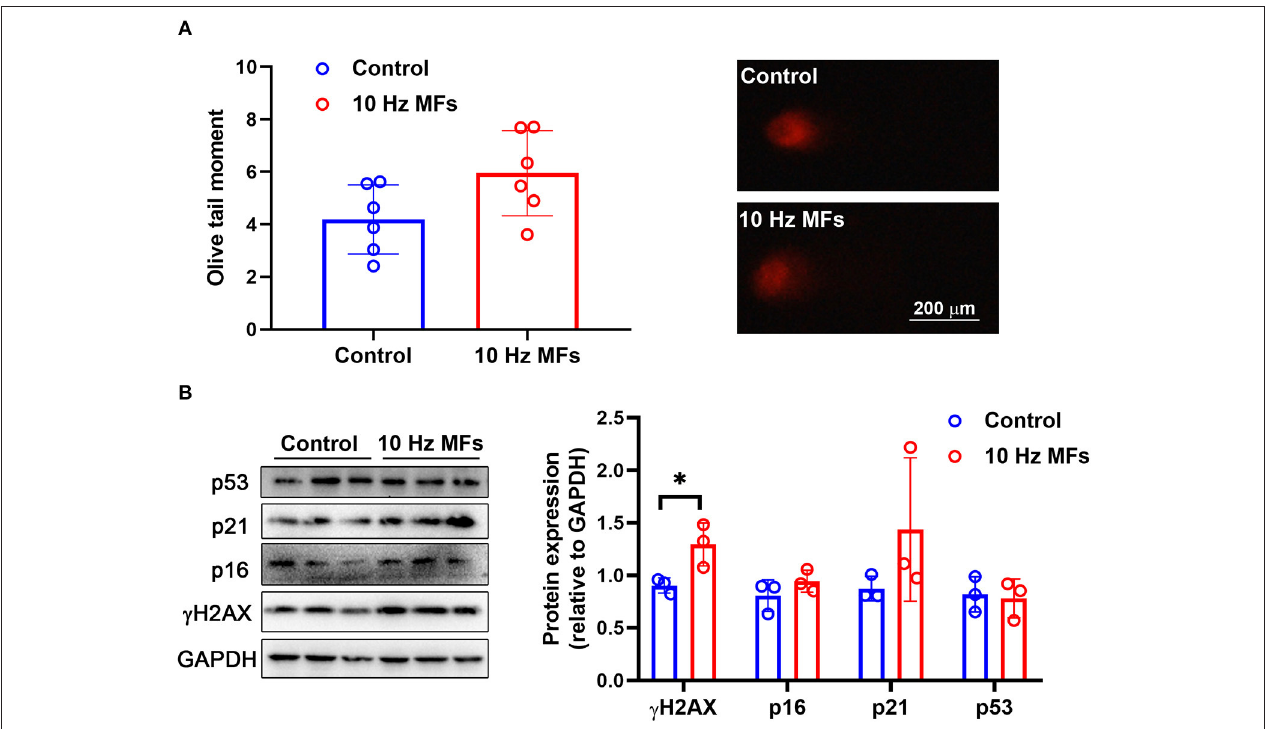
FIGURE 1 | The effect of 10Hz pulsed MFs exposure on DNA damage and p16, p21, and p53 expressions in 2BS cells. (A) The statistical values of DNA fragmentation (Olive tail moment) in 2BS cells of control and 10Hz pulsed MFs exposure group and representative images of alkaline comet assay; (B) the statistical graphic of protein expression (relative to GAPDH) and blot images of γ H2AX, p16, p21, and p53 in 2BS cells. All data were presented as mean ± SD. * P <